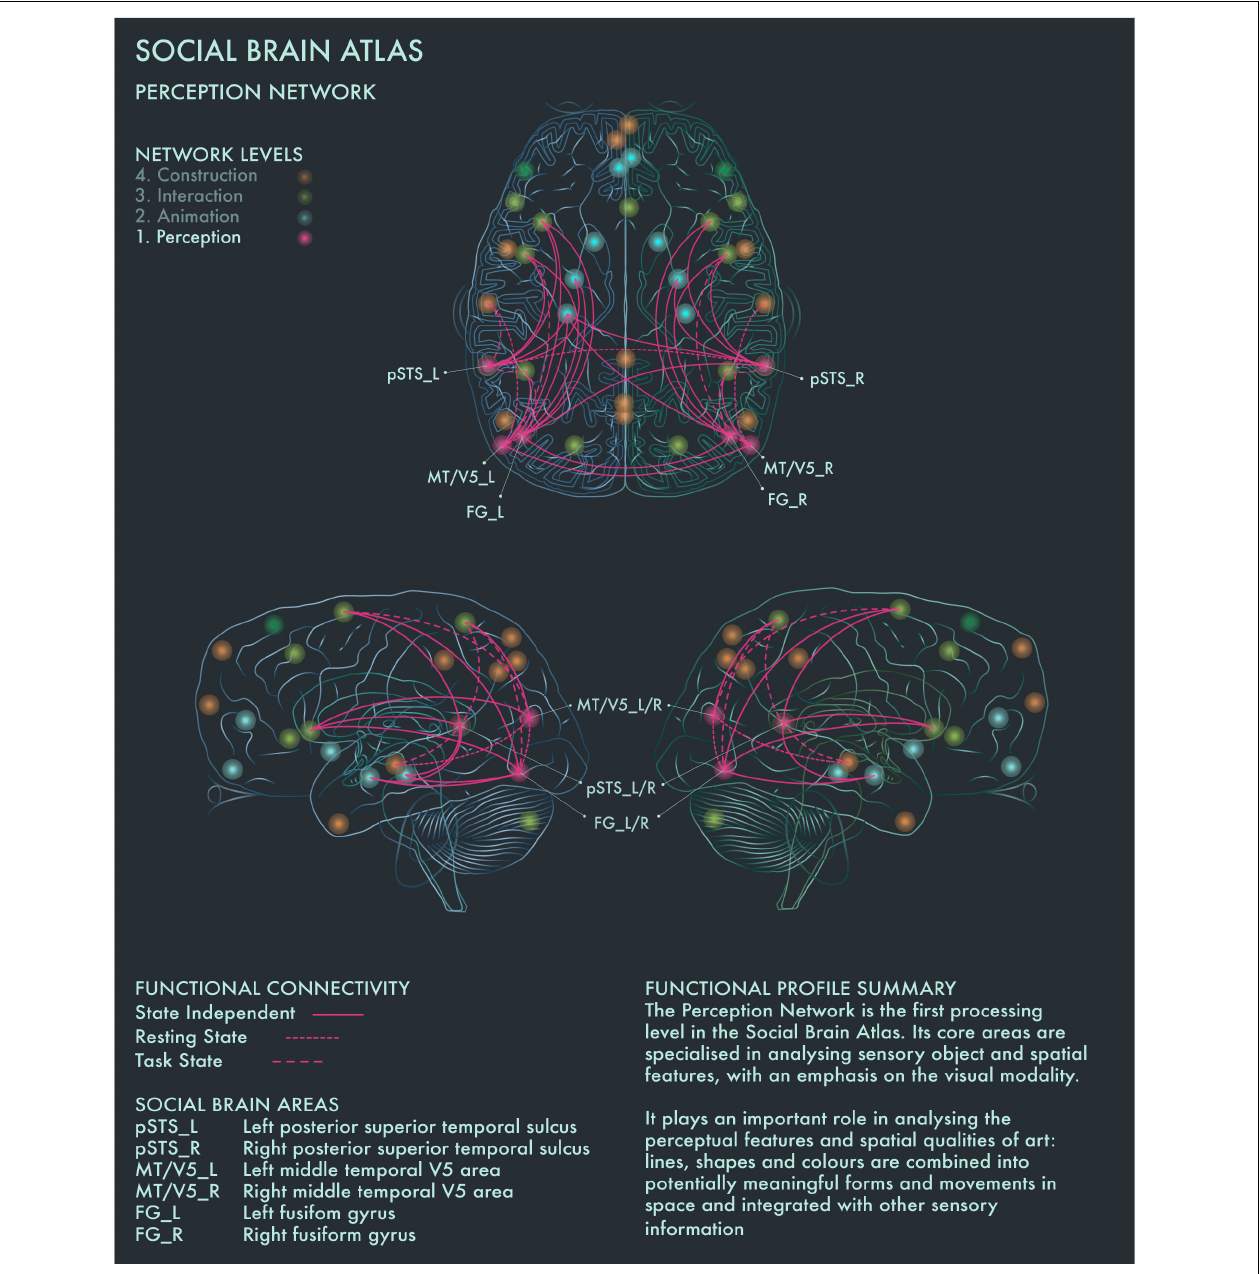
FIGURE 1 | Social Brain Atlas Level 1: Perception Network. This figure shows the functional connectivity patterns of the Perception Network (PN), based on data derived from Alcalá-López et al. (2017) (see also Table 1(A) ). The core nodes of the PN have been labeled as follows: Bilateral posterior superior temporal sulcus (pSTS_L/R); Bilateral middle temporal V5 area (MT/V5_L/R); Bilateral fusiform gyrus (FG_L/R). Areas beyond the PN to which these core nodes project are not labeled. Functional connections have been drawn as lines; a solid line indicates a functional connection independent of the brain state, a wide dotted line indicates a task-dependent functional connection and a narrow-dotted line indicates a functional connection during a brain state with no output task (the resting state). The PN is the first processing level in the social brain connectome Its core areas are specialized in analyzing sensory object and spatial features, with an emphasis on the visual modality. It plays an important role in analyzing the perceptual features and spatial qualities of art: lines, shapes and colors are combined into potentially meaningful forms and movements in space and integrated with other sensory information.